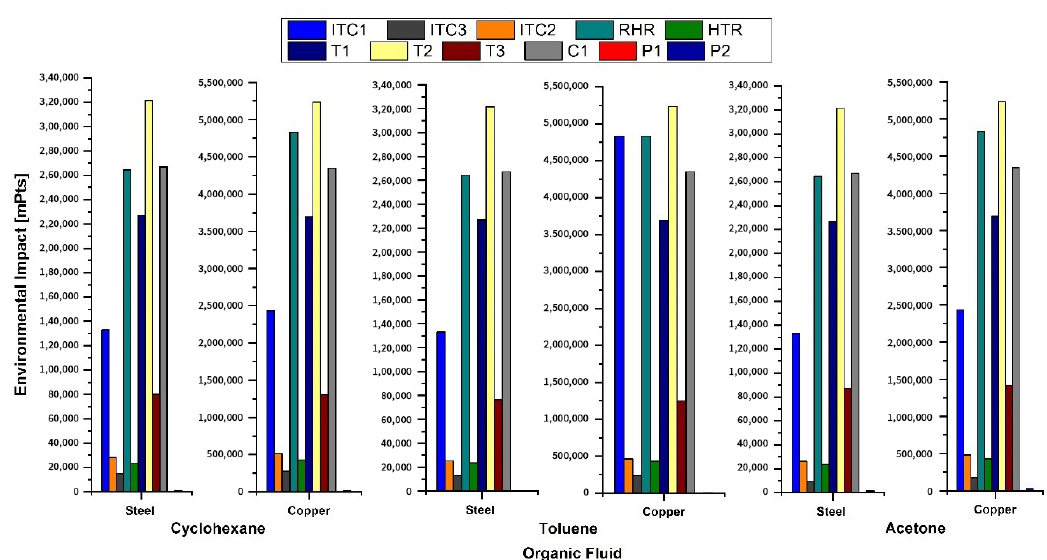
Figure 10. Environmental impact of each equipment with respect to the organic fluids and